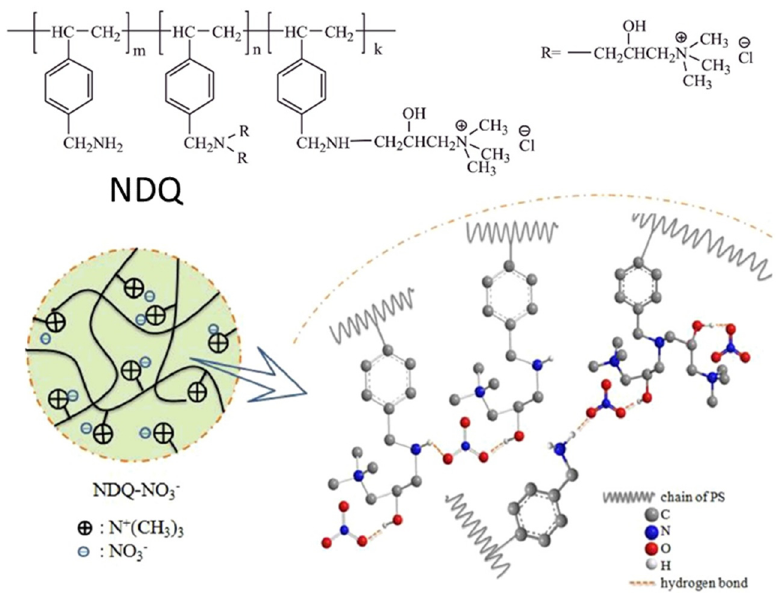
Figure 11. PS modified with amino and quaternary ammonium copolymer (NDQ) and nitrate binding mechanism through hydrogen bonding. Adapted with permission from [152]. Copyright © Elsevier 2016.